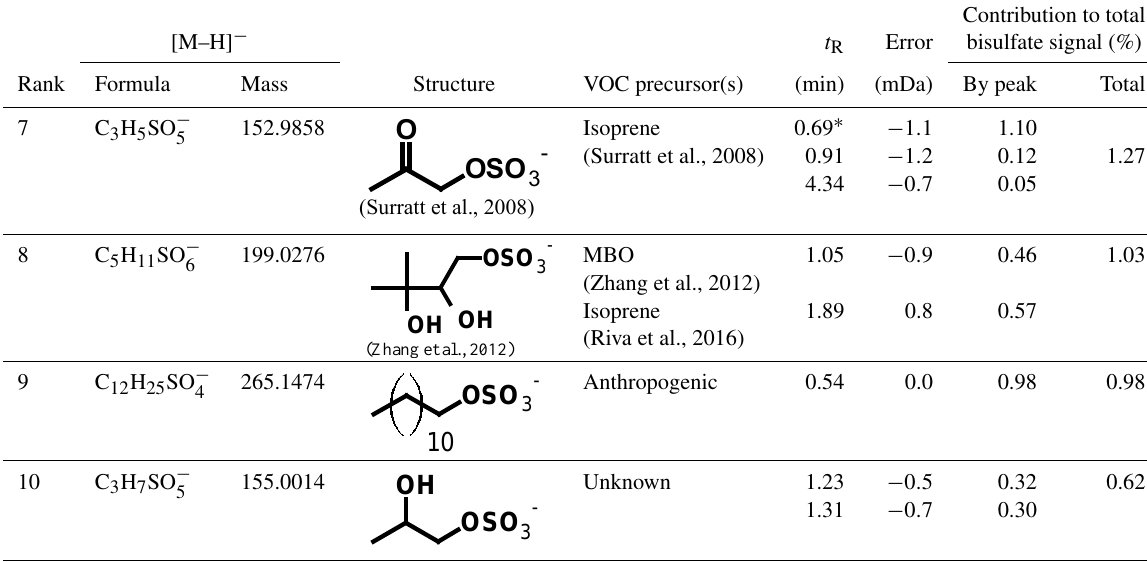
Figure 2. The mass spectrum of precursors of m/z 97 (HSO − the daytime sample collected on 10 July 2013 using HILIC–TQD. The 10 labelled m/z correspond to the deprotonated ions ([M–H] − ) of organosulfates with the greatest